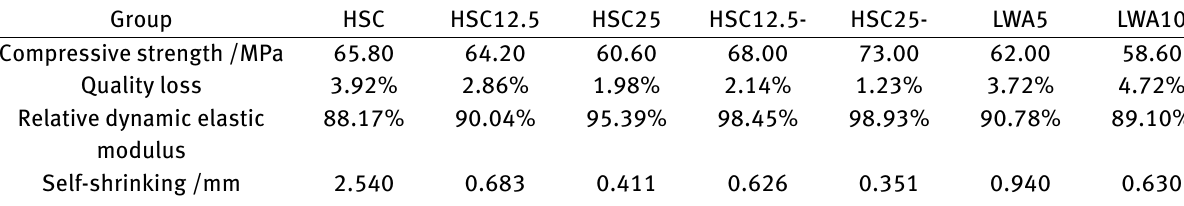
Table 2: Measurement results of concrete performance indexes